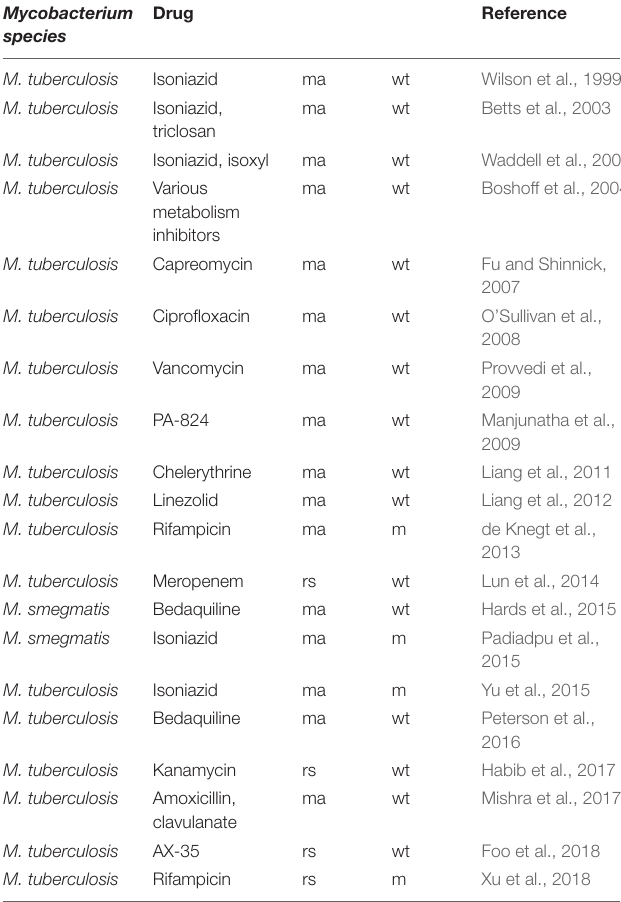
TABLE 1 | Chronology of publications cited in this review on transcriptomic profiling by microarray (ma) or RNA-seq (rs) after anti-bacterial compound